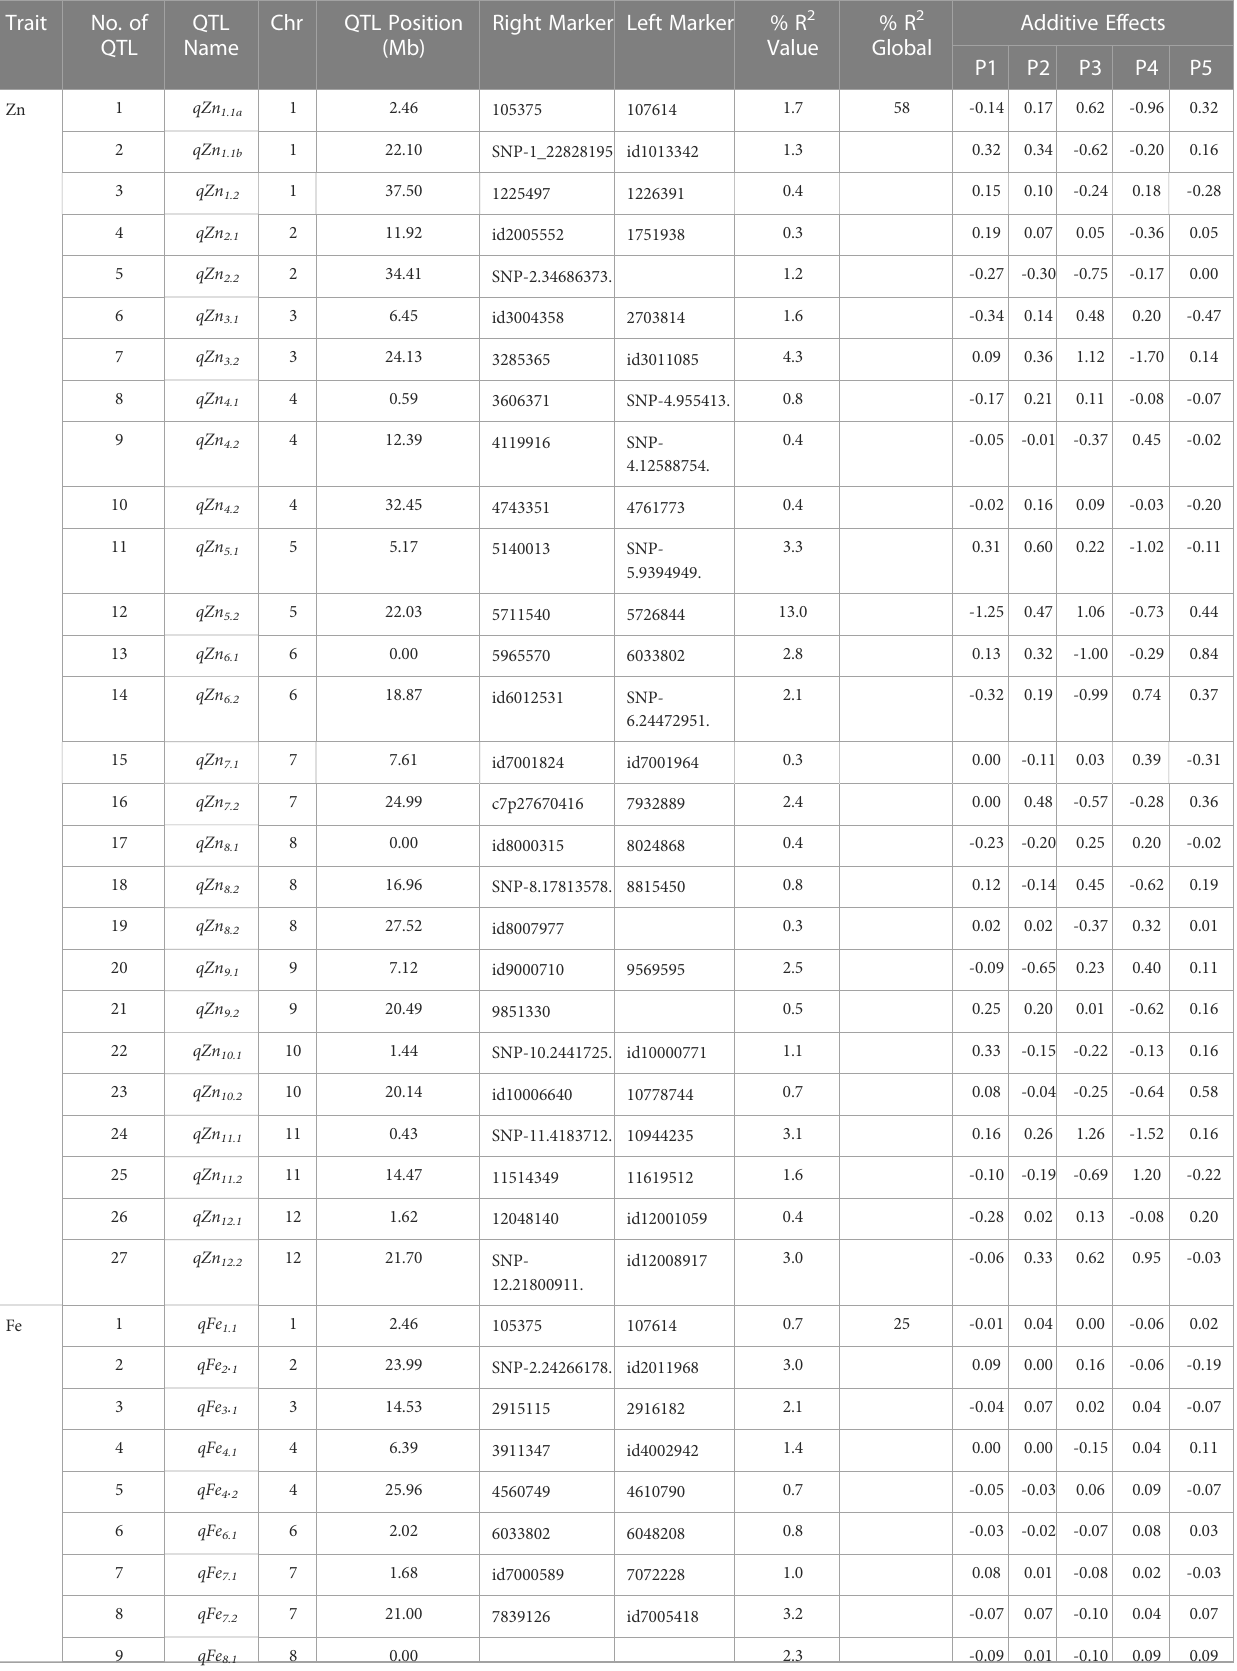
TABLE 2 QTL detected for Zn, Fe, GY, and GY-related traits of four connected populations using MC-QTL. Trait No. of